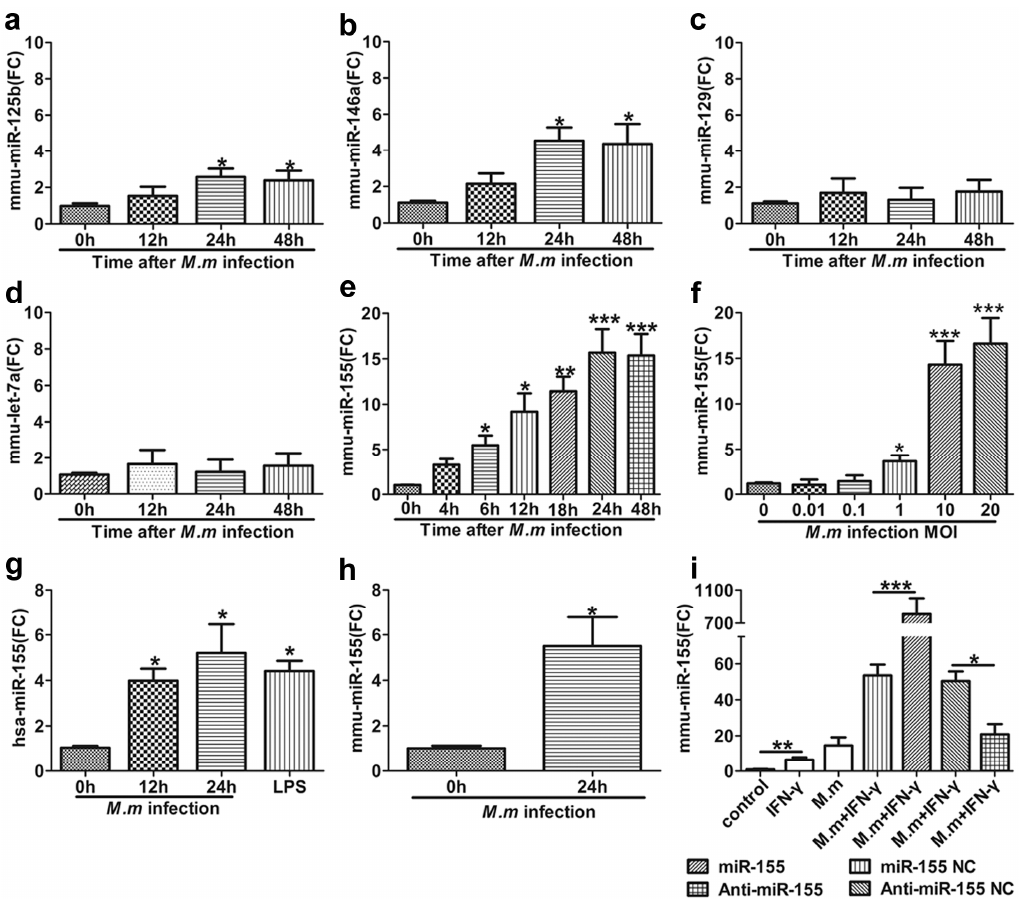
Figure 1. Distinguishing expression of miRNAs in M.m infected macrophages. ( a – e ) Expression